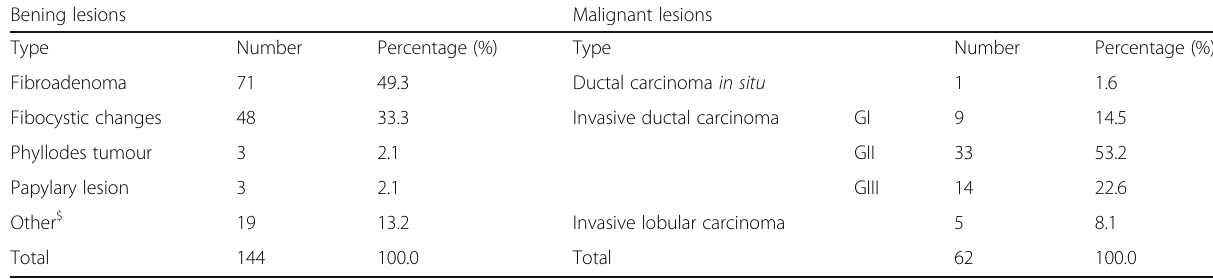
Table 1 Histopathology of the 206 solid lesions at percutaneous core-biopsy Bening lesions Malignant lesions Type Number